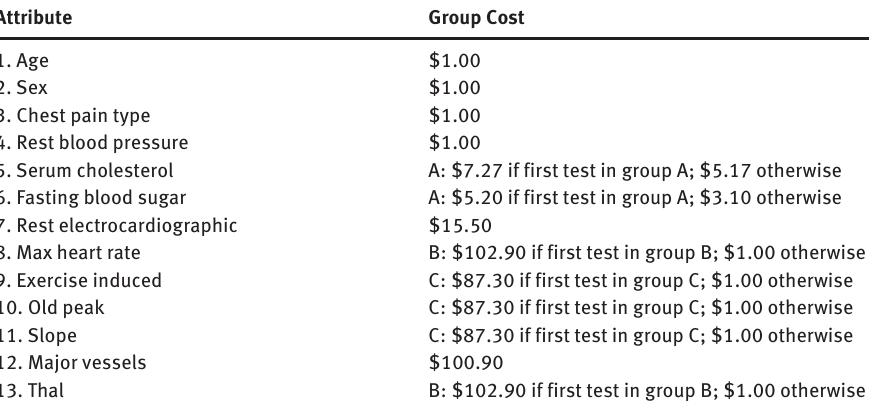
Table 10. Measurement Cost of Attributes in Heart Disease Data Set. Attribute